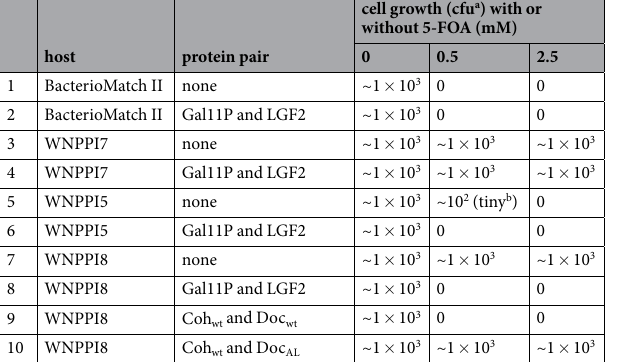
Table 2. Examination of negative selection host strains a . a cfu, colony-forming unit. b In comparison to the regular colony size (~1 mm) from other tests, these colonies ( < 0.1 mm) were barely seen by